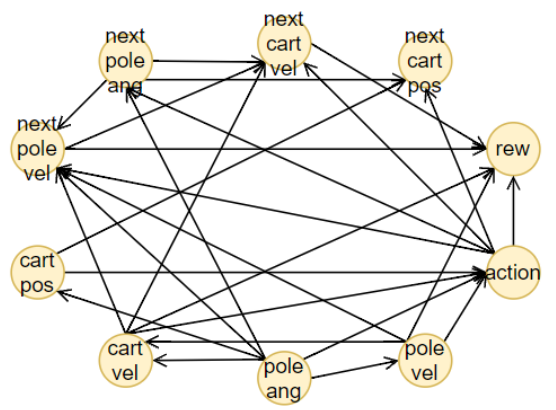
Figure 11. Structure of the BN for the Cartpole environment. The names of the nodes represent the following features: “cart pos” is the cart position, “cart vel” is the cart velocity, “pole ang” is the pole angle, “pole vel” is the pole velocity, “action” is the action, “rew” is the reward, “next cart pos” is the next value for the cart position, “next cart vel” is the next value for the cart velocity, “next pole ang” is the next pole angle, “next pole vel” is the next value for the pole velocity. Table 2. AUROC and accuracy for the prediction of each future feature in the Cartpole environment. Parameter